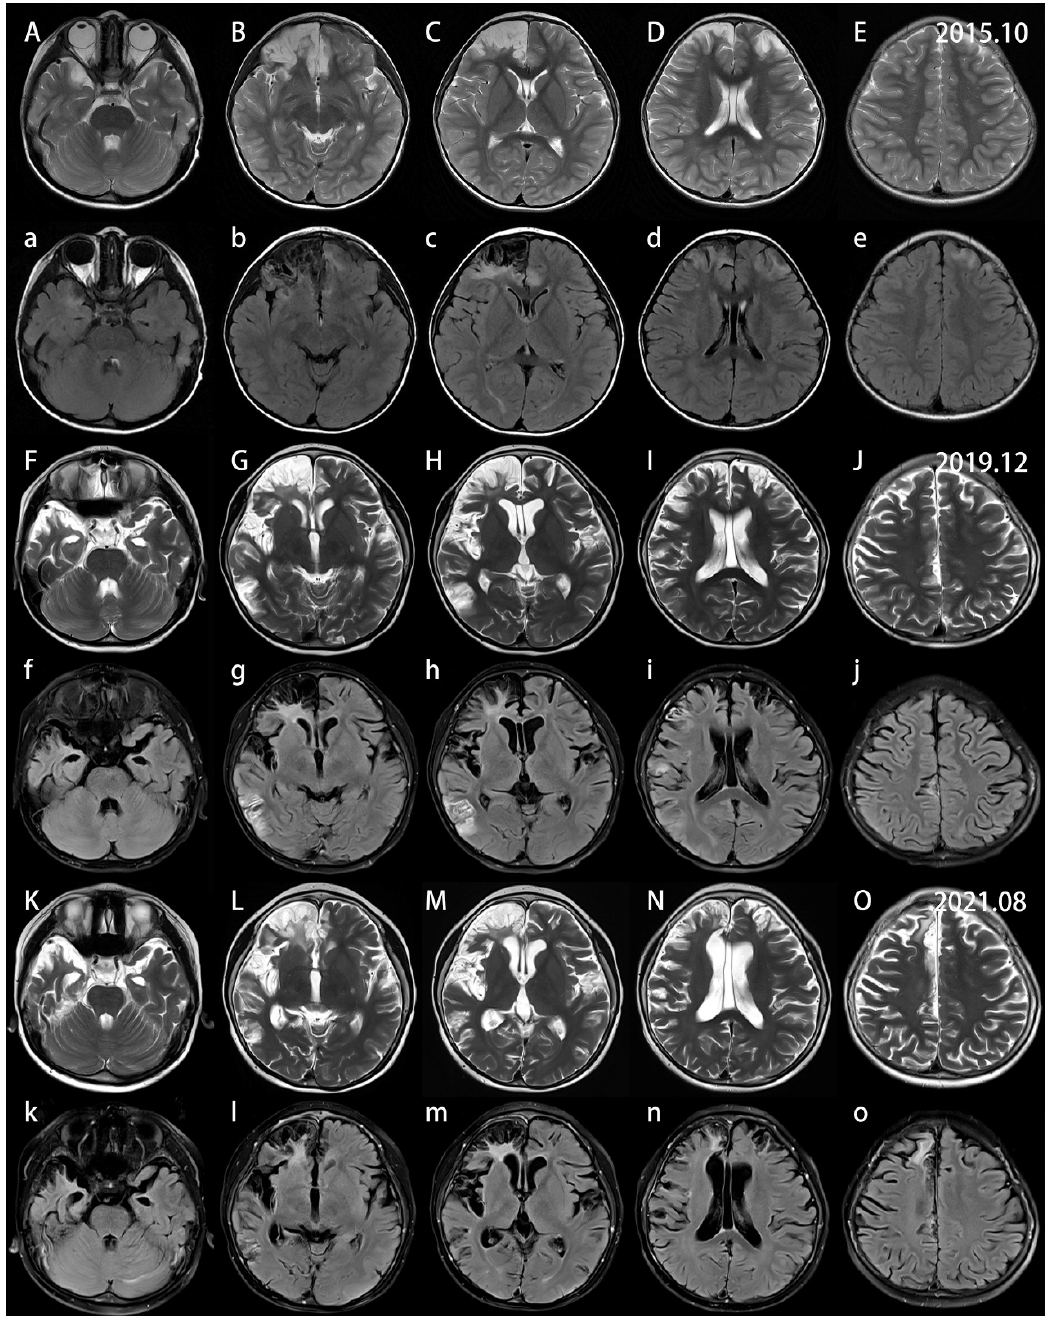
Figure 1. Control brain magnetic resonance imaging (MRI) of the patient at the initial onset of the disease in October 2015, palindromia in December 2019 and stable period after rituximab in August 2021. Axial T2-weighted ( A – O ) images and axial FLAIR-weighted ( a – o ) images show prominently progressive cortical and subcortical atrophy and encephalomalacia in the right frontal, temporal and insula lobes, and slowly progressive focal atrophy in the contralateral frontal and insular lobes. The new patchy lesions around the old lesions are revealed clearly on axial FLAIR-weighted ( a – o ) images. The bilateral lateral ventricles and lateral fissure districts dilated, particularly as the disease progressed in December 2019 ( F – J , f – j ), but the lesions seemed to be under control to some extent with rituximab treatment ( K – O , k – o ).